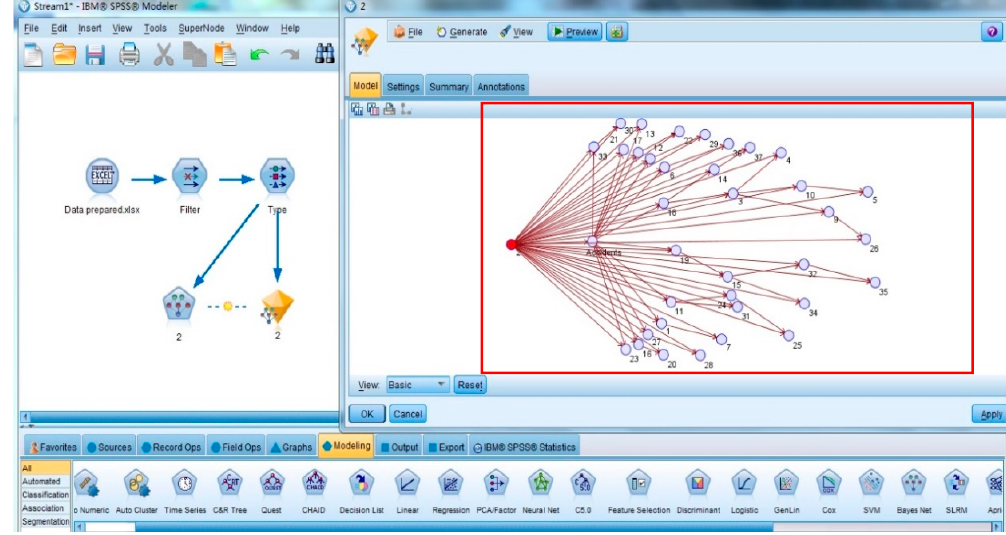
Figure 2. The structure of the BNMBCA with B 2 as the root node. Table 2. The CPT of the four types of accidents when B 2 is identified as the root node Root Node